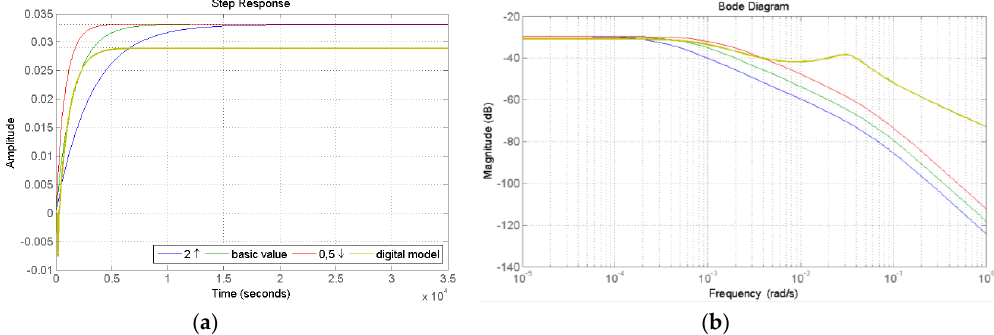
Figure 3. Segment G1 step ( a ) and frequency responses ( b ) for simulation of changes in thickness of absorber.